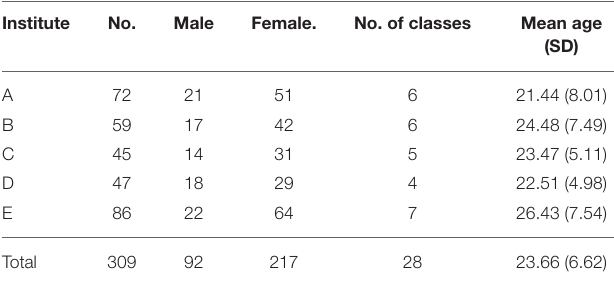
TABLE 1 | Demographic information of